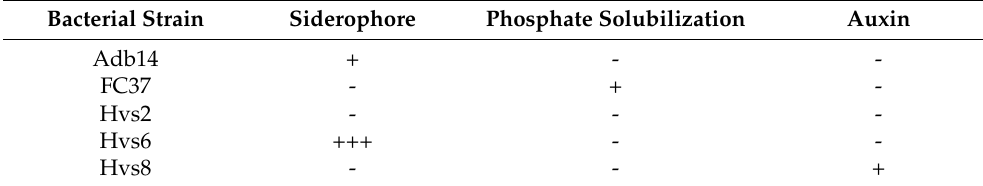
Table 2. Plant growth promoting compounds produced by bacterial strains Adb14, FC37, Hvs2, Hvs6 and Hvs8. Bacterial Strain Siderophore Phosphate Solubilization Auxin